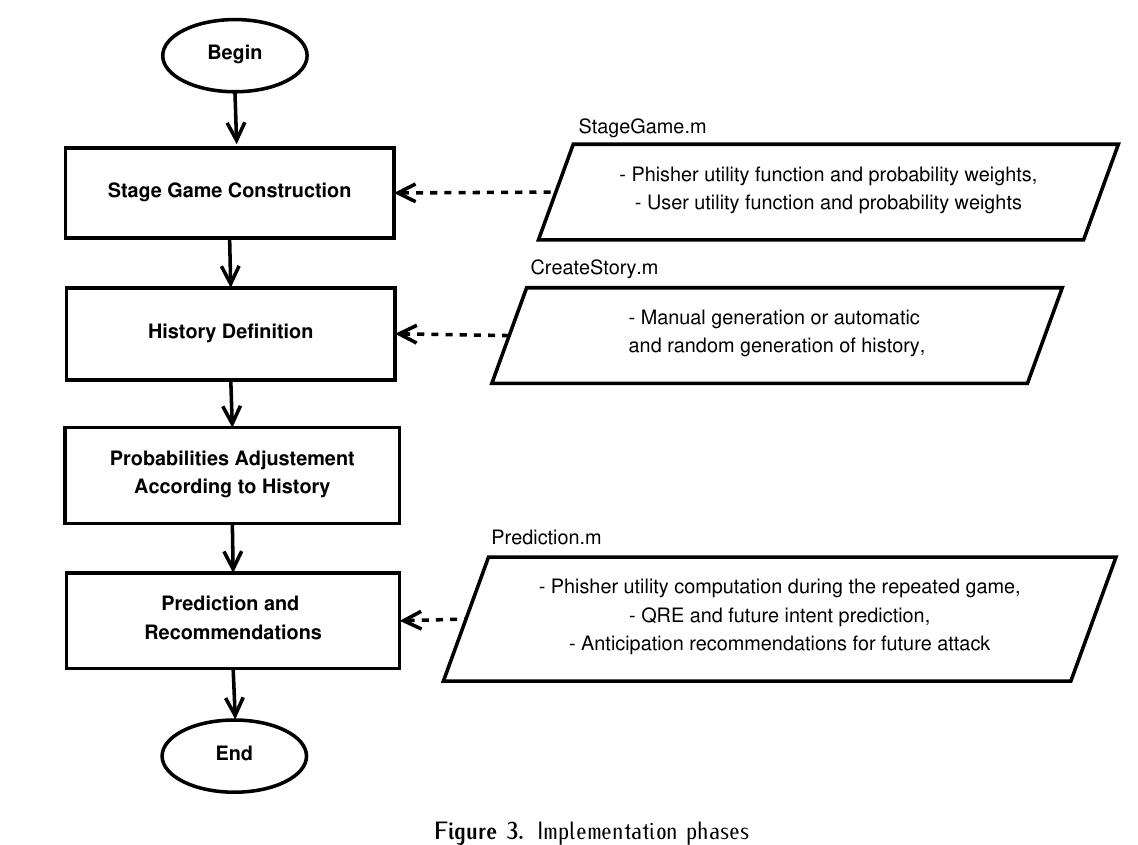
Figure 3. Implementation